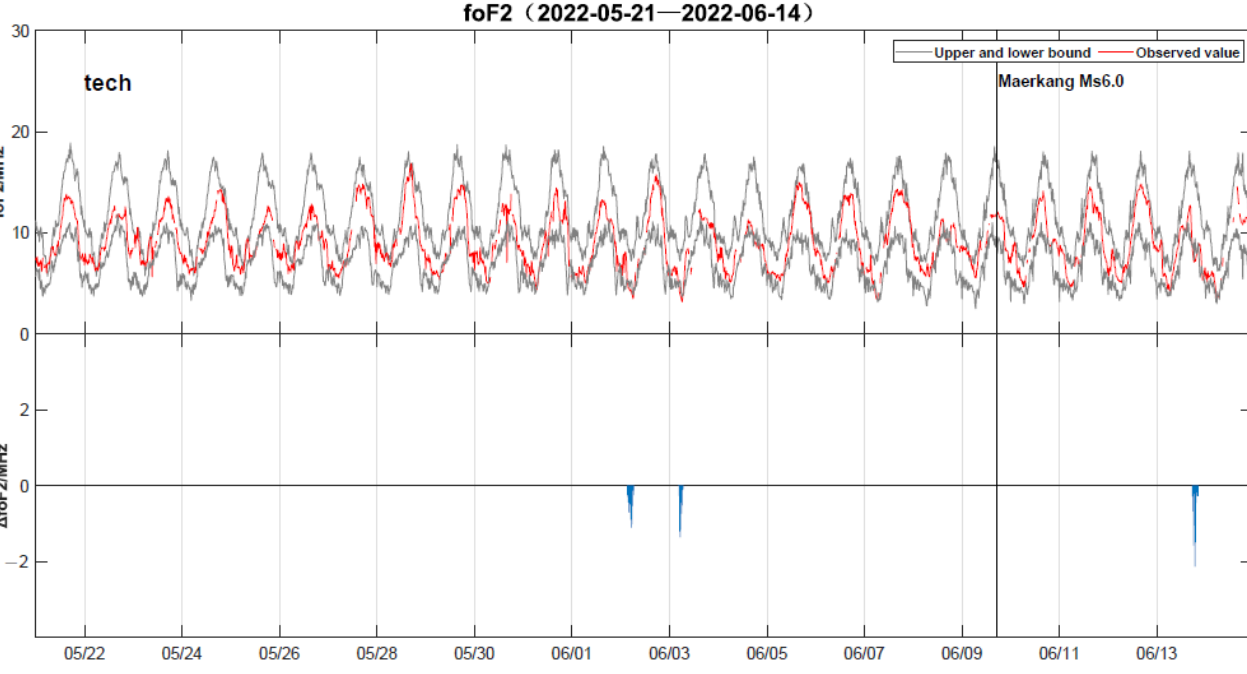
Figure 5. Temporal variations of f O F 2 from the Tengchong vertical ionosonde station. The time of earthquake is annotated by the black line, the upper and lower bounds are shown in gray, and observed values are shown in red. The abnormal values are shown in blue, represented as ∆ f O F 2 .